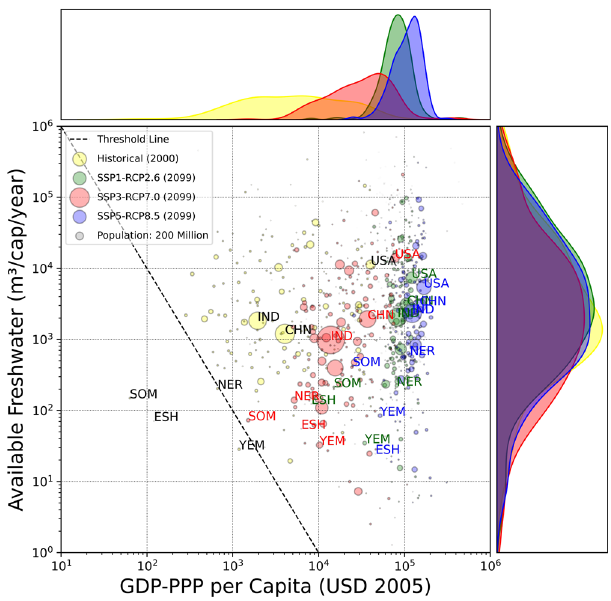
Fig. 1 Country-level scatter plot for APC vs GDP-PPP per capita and density plot considering the number of countries for various socioeconomic and climate scenarios. Each circle corresponds to a country, and the circle ’ s size corresponds to the country ’ s population. CHN, ESH, IND, NER, SOM, USA, and YEM represent China, Western Sahara, India, Niger, Somalia, United States of America and Yemen, respectively. Yellow, green, red, and blue colours represent the historical, SSP1 – RCP2.6, SSP3 – RCP7.0, and SSP5 – RCP8.5 scenarios, respectively, and the dashed line represents the threshold value for physical and economic water scarcity. The analysis was performed considering the GPWv4 dataset for the historical, i.e., the year 2000 population and MY19 for the future, i.e., the year 2099